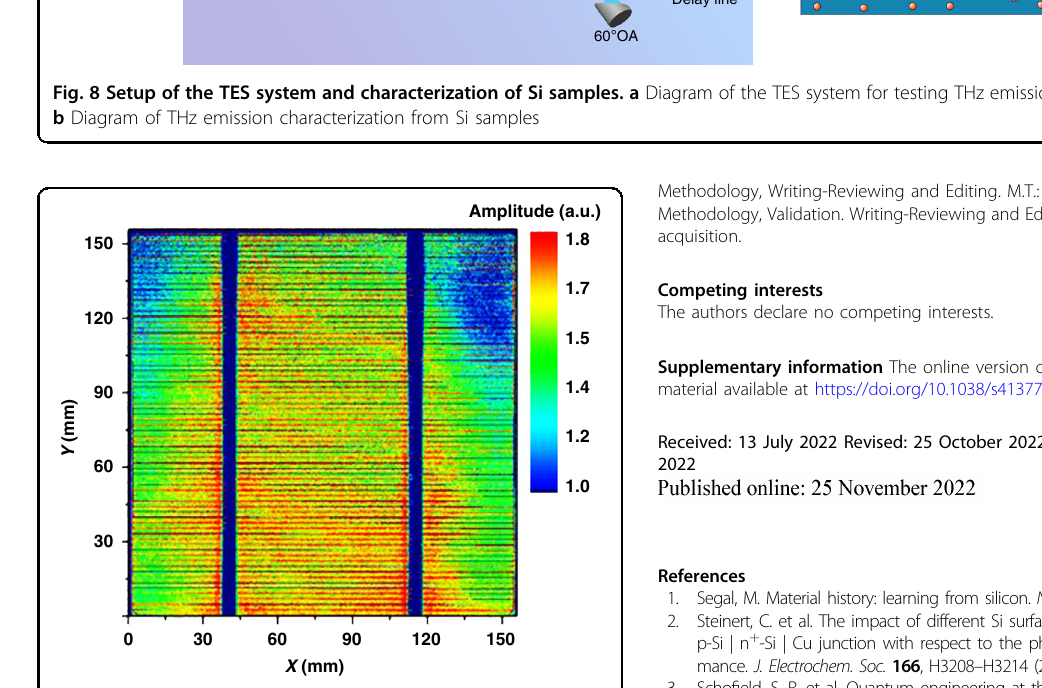
Fig. 9 LTEM image of a solar cell. The LTEM image of a large-scale solar cell of 156 mm × 156 mm (781 × 781 pixels reverse bias voltage: 10 V) 50 . (Reproduced from Ref. 50 , with permission of EU